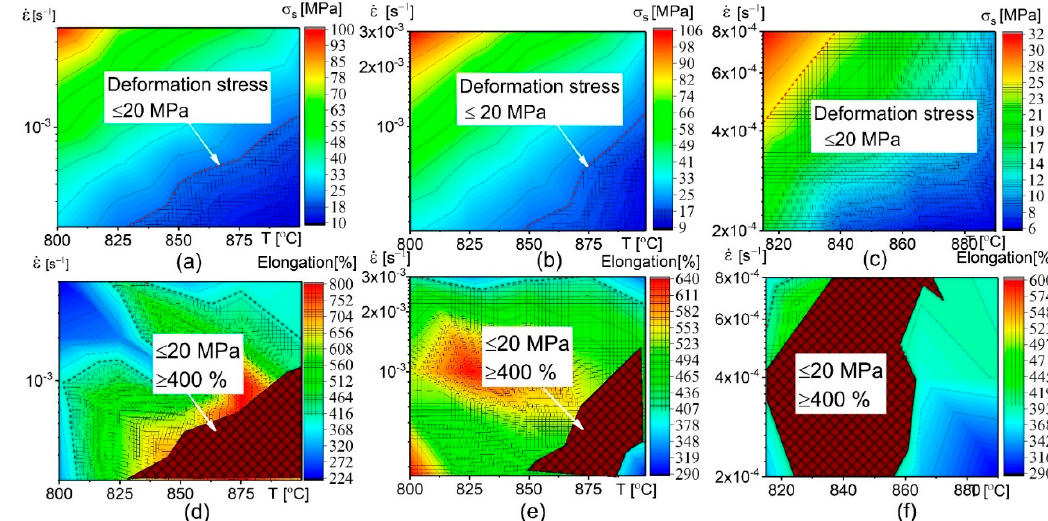
Figure 6. Stress at the start of the steady stage ( σ s ) and elongation to failure dependence on both the deformation temperature and strain rate for the tested alloys: Ti-3%Mo-1%V-4%Al alloy ( a , d ); Ti-4%V-6%Al alloy ( b , e ); and Ti-1.8%Mn-2.5%Alalloy ( c , f ).